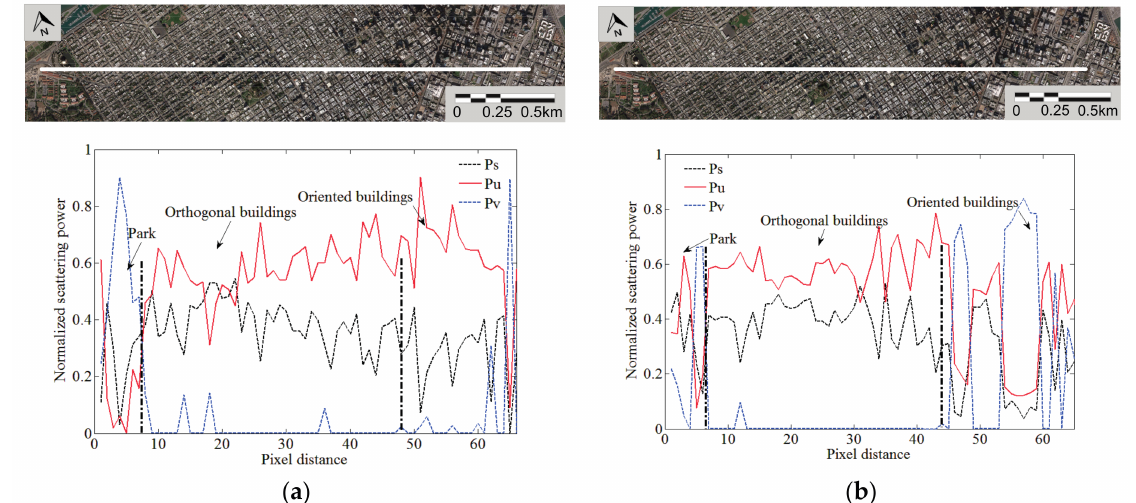
Figure 13. Profile of decomposition scattering power: ( a ) Radarsat-2 C-band data; and ( b ) ALOS PALSAR L-band